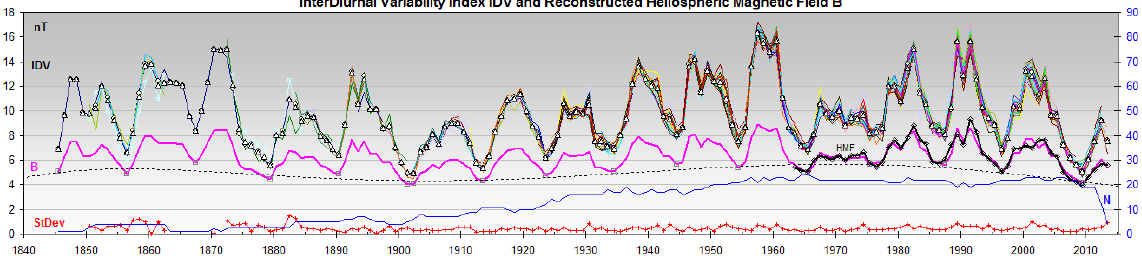
Figure 6. Reconstruction of annual means of 169 years of near-Earth heliospheric magnetic field strength B (pink line in middle of graph) for the interval 1845–2013 compared with in situ spacecraft measurements (black line marked HMF) plotted using different colors for each station, from Svalgaard and Cliver (2014). Open triangles (or circles) show the median (or mean) of all stations in each year. The red line at the bottom of the graph shows the standard deviation of the values of IDV in each year. The blue line marked N shows the number of stations for each